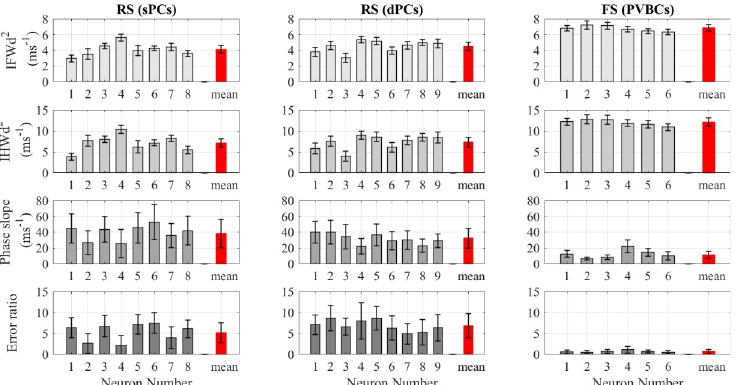
Fig 3. The AP rapidity calculated using the four quantification methods for hippocampal neurons. Comparison between the onset rapidity quantification methods applied to hippocampal neuron APs. All the values here are obtained using the spline interpolation function except for phase slope values, which were obtained using the pchip interpolation function. https://doi.org/10.1371/journal.pone.0247242.g003 The hippocampal neuron’s conventional RSD of the spike train rapidity measured using the IFWd 2 method was 17.4% for RS pyramidal neurons and 8.0% for FS PVBCs. Correspond- ing RSDs using the IHWd 2 method were 24.4% and 9.6%. The error ratio method had a high relative variation with RSDs of 42.0% and 73.3%, respectively. For the hippocampal neurons, the phase slope method produced the highest variation with 147.9% and 61.2% RSDs, respec- tively, for RS pyramidal neurons and FS PVBCs. Strikingly, the € V peak width methods indi- m cate that the FS PVBC have more rapid onset than the RS neurons, similar to the cortical neuron results, while the error ratio and the phase slope methods gave the opposite relation. The error ratio’s much smaller mean and SD values for FS hippocampal neurons can be attrib- uted to the data selection, which is discussed in a following section. Also, the high variation in the phase slope value was due to low sampling rates, motivating the adoption of a different interpolation function for further analysis using the phase slope method as discussed in the next section. Impact of sampling rate and interpolation method. Sampling rates used during data acquisition and interpolation formulas impact AP onset rapidity, especially when quantified with the phase slope or error ratio methods. For hippocampal RS pyramidal neuron record- ings, the phase slope method produced high standard deviations, which can be attributed to the sampling rate of the recordings and the interpolation function. The sampling rate for the hippocampal recordings was 10 kHz, giving one data point every 100 μ s. In contrast, the sam- pling rate for the cortical recordings analyzed in this paper was 20 kHz. The lower sampling rate (i.e., the longer time between consecutive samples of V in hippocampal recordings) m Table 2. The mean and standard deviation of rapidity for RS hippocampal neurons for each quantification method using pooled statistics. Interpolating